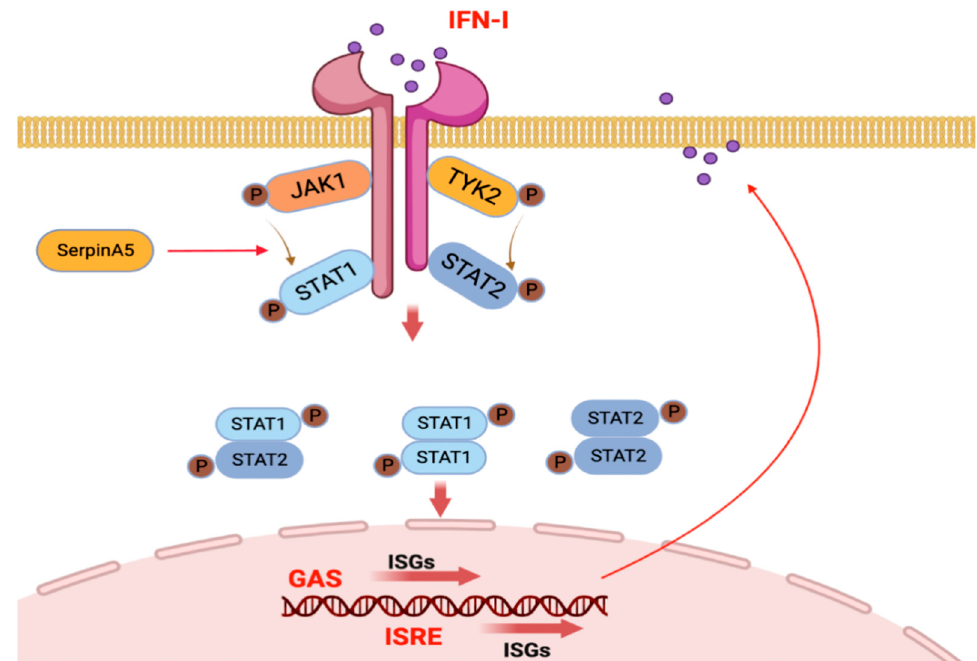
Figure 5. Pattern to illustrate the SerpinA5-involved innate immune signaling in response to viral infections. SerpinA5 can interact with STAT1 and upregulate the phosphorylation of STAT1 by promoting the recruitment of JAK1 kinase, and thus facilitate the formation of STAT1/STAT2 complex and its nuclear translation to bind to the ISRE (interferon-stimulated response element) and GAS ( γ -activated sequence) sites. Subsequently, the transcription of IFN-stimulated genes (ISG) is initiated, and IFN-related signaling pathways are effectively activated to impair viral infections. This figure was created by BioRender.com.